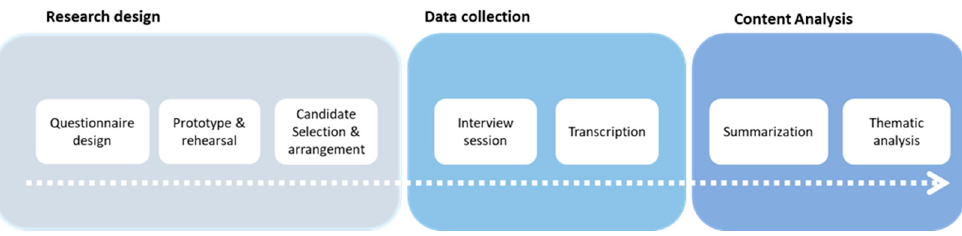
Figure 1. Interview process by research design, data collection, and content